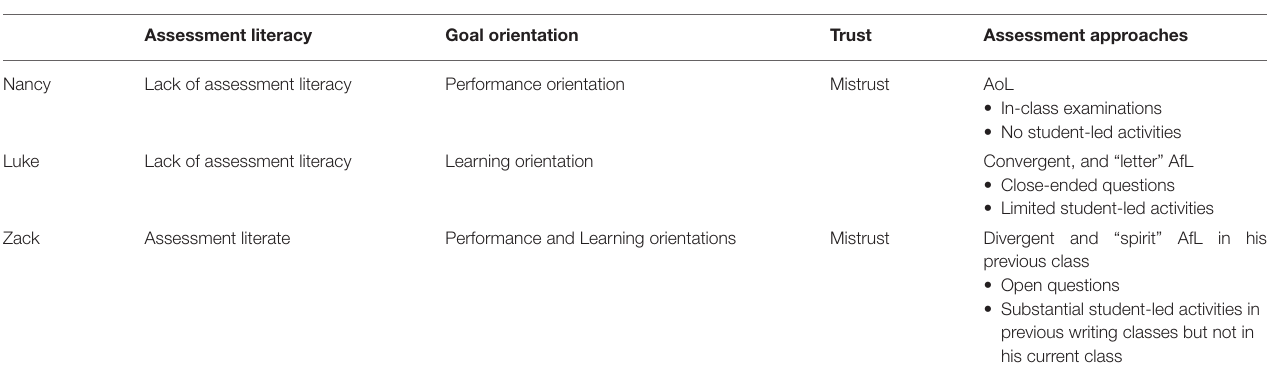
TABLE 2 | Summary of the major